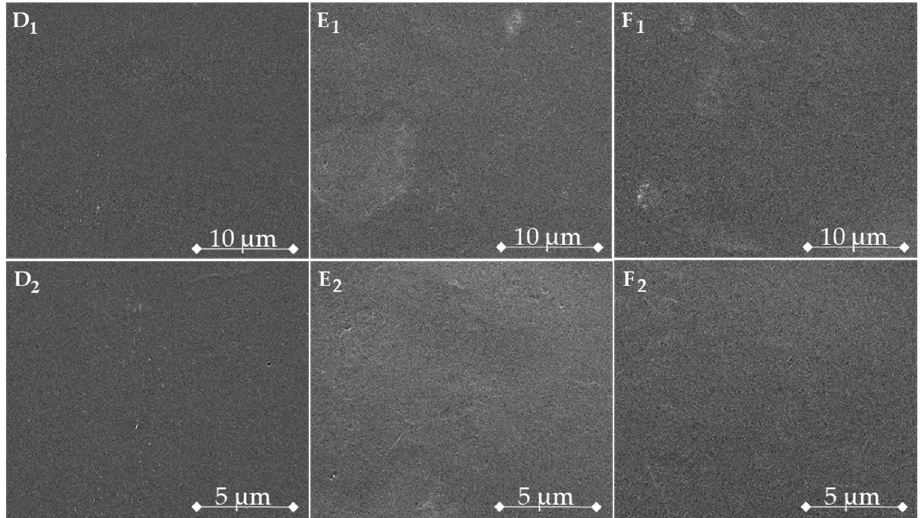
Figure 4. SEM images of CHT-GEL ( A1 , A2 ), CHT-GEL-GEN ( B1 , B2 ), CHT-GEL-GEN-GO05 ( C1 , C2 ), CHT-GEL-GEN-GO1 ( D1 , D2 ), CHT-GEL-GEN-GO2 ( E1 , E2 ), CHT-GEL-GEN-GO3 ( F1 , F2 ) films at two different magnifications (1—10,000×, 2—20,000×).